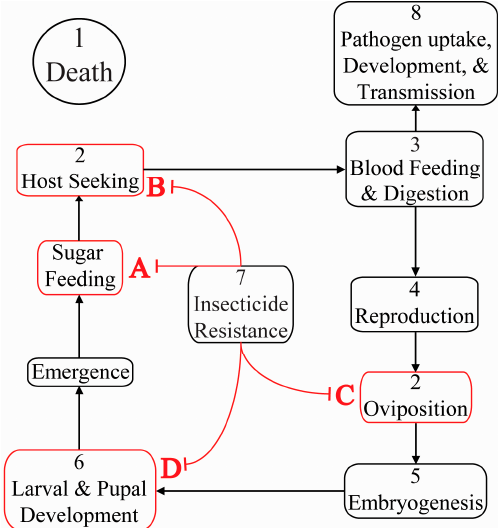
Figure 1. Mosquito life cycle events in the context of RNAi interventions (see also Table